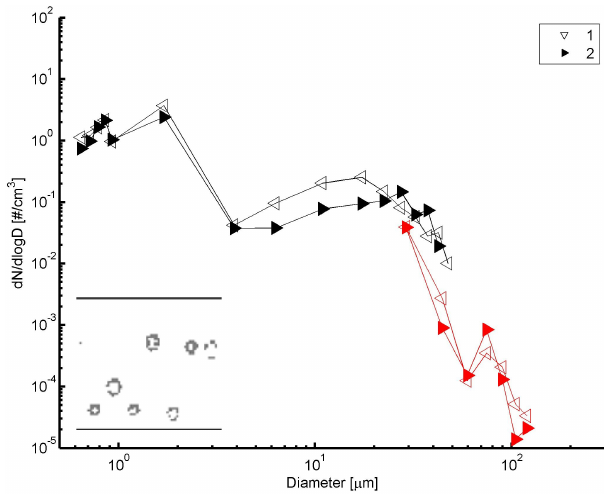
Fig. 9. Average particle size distribution d N /dlog D p recorded dur- ing the overpass run (Run 1) for the CAS (black) and CIP-GS (red) probe. Legend denotes passes, times are indicated in the main